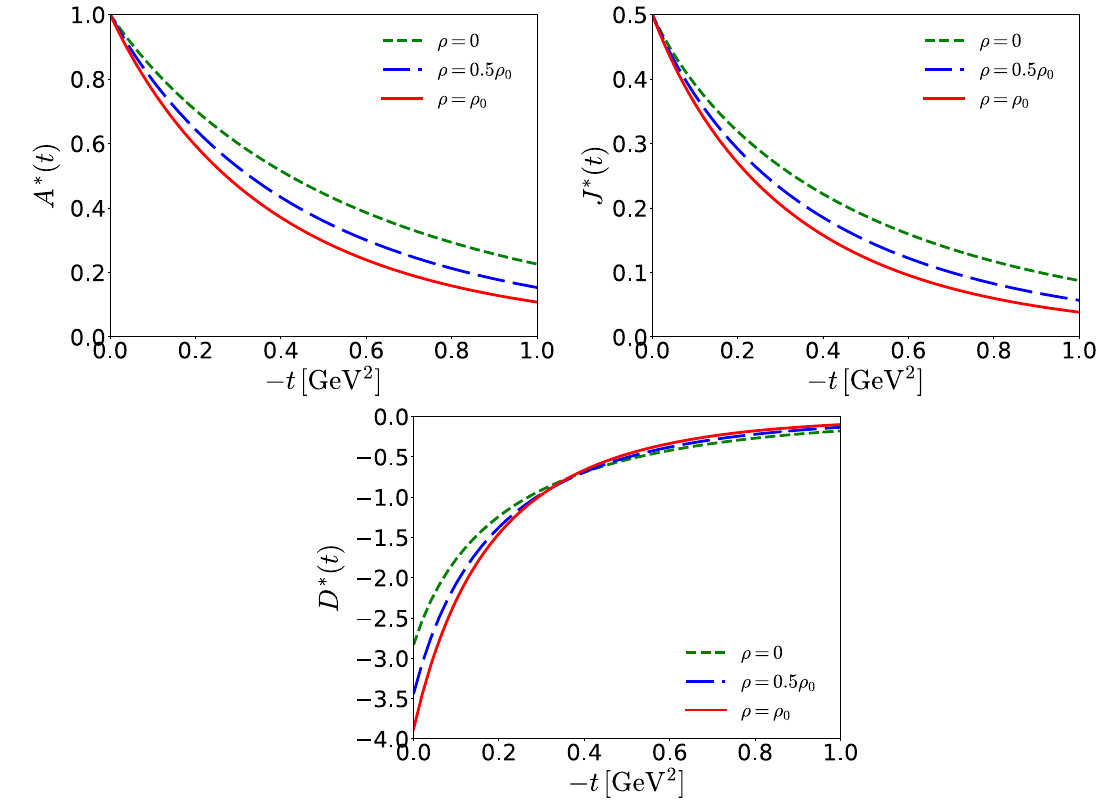
Fig. 1 The GFFs A ∗ ( t ), J ∗ ( t ) , and D ∗ ( t ) of the nucleon as functions of the momentum transfer t . The short-dashed curves draw those in free space, whereas the long-dashed and solid ones depict those respectively at ρ = 0 . 5 ρ 0 and at ρ = ρ 0 , where ρ 0 = 0 . 5 m 3 π is the normal nuclear matter